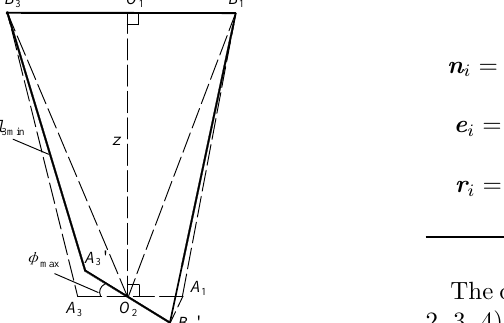
Table 1: The vectors used in Figure 6 ( i =1, 2, 3, 4) Figure 5: The rotation extreme position of the moving Figure 4: The extreme position of the MP along x axis platform around y axis positive direction Figure 4: The extreme position of the MP along x axis positive direction The maximum rotation is achieved when one actuator reaches the minimum length and the other reaches the maximum. The rotation range of the moving platform around y axis is calculated as follows: